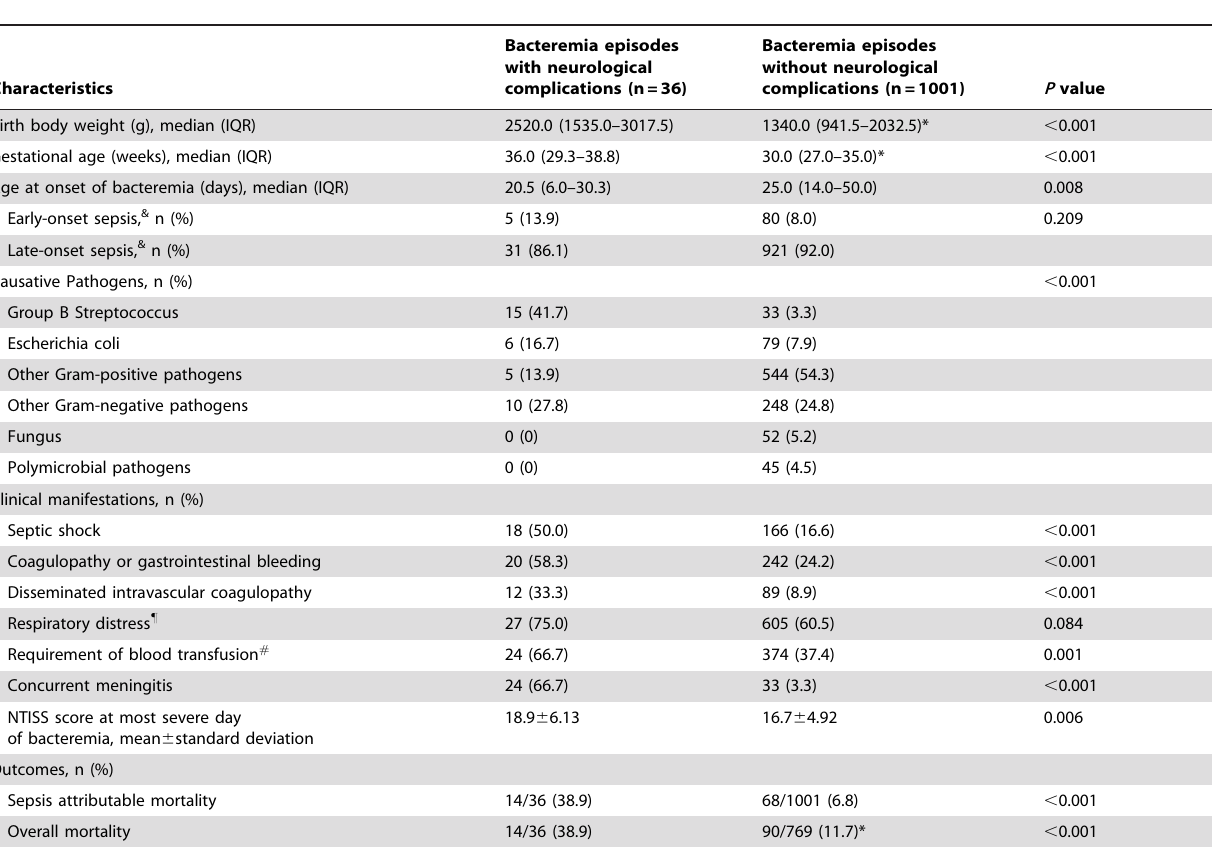
Table 1. Clinical and laboratory features in neonates with bacteremia-associated neurological complications among 1037 episodes of bacteremia in the neonatal intensive care unit.